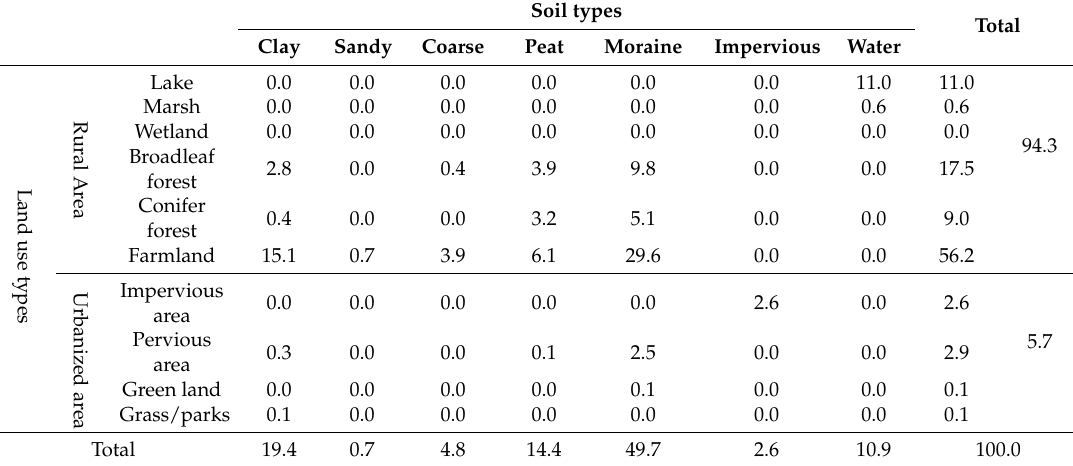
Figure 5. Daily synthetic rainfall (P Case1 ~P Case6 ) and calculated discharges simulated by HYPE COR and HYPE UA by using each SR (HYPE COR1 ~HYPE COR6 , HYPE UA1 ~HYPE UA6 ). Details of SRs were described in Section 2.3.